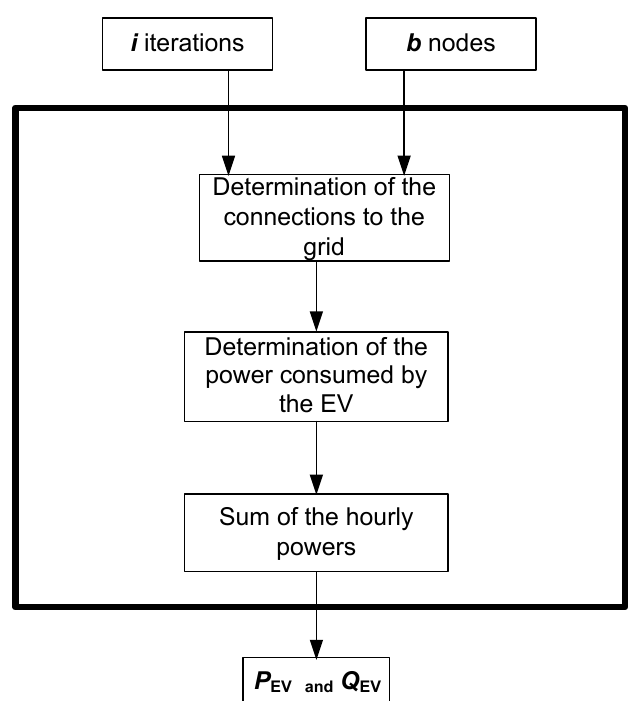
Figure 4. Flow diagram of the process “ Sample generation for EV active and reactive power ( P and Q ) EV EV